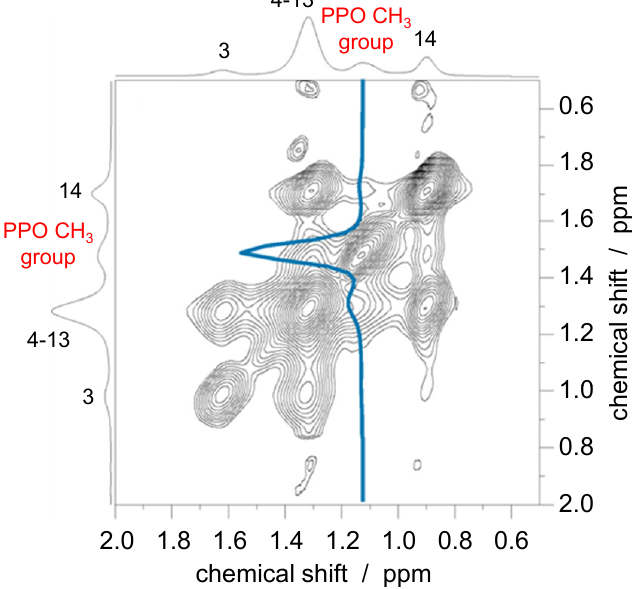
Figure 6. Acyl chain signal region of a 2D 1 H– 1 H NOESY spectrum of the sample dimyristoylphosphatidylcholine (DMPC)/F-GP polymer (5 mol %) measured at 4 kHz magic-angle spinning (MAS), a temperature of 40 ◦ C and a mixing time of 200 ms. The base level of the counter plots is set to 5% of the highest intensity. The blue line represent a slice at the position of the PPO-methyl resonance in the ω 1 -dimension. Figure adapted from ref. [16] published by the Royal Society of